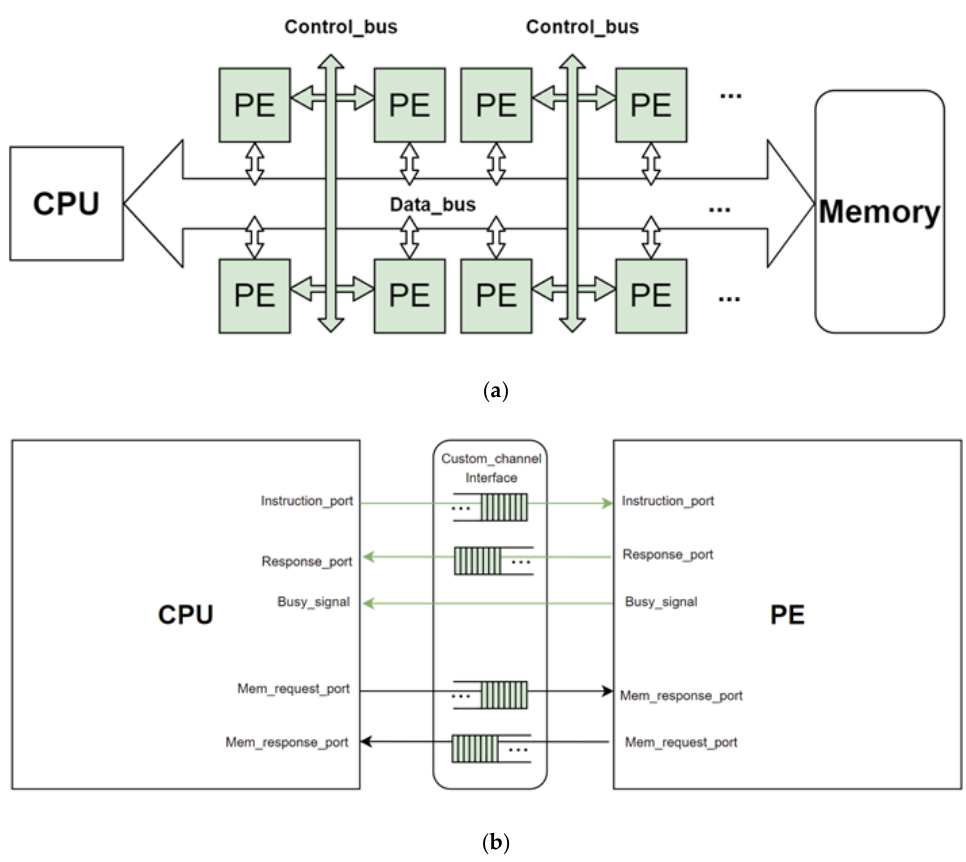
Figure 1. ( a ) The CPU controls the sub-module by reading and writing registers through the data bus and the control bus. ( b ) The CPU controls the sub-module by transmitting information through the custom instruction